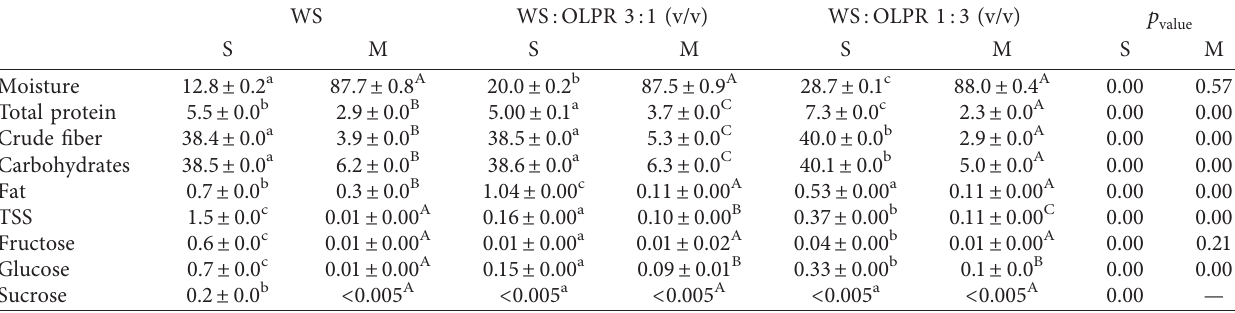
Table 4: Mushroom (% fresh weight) and substrate (% dry weight)